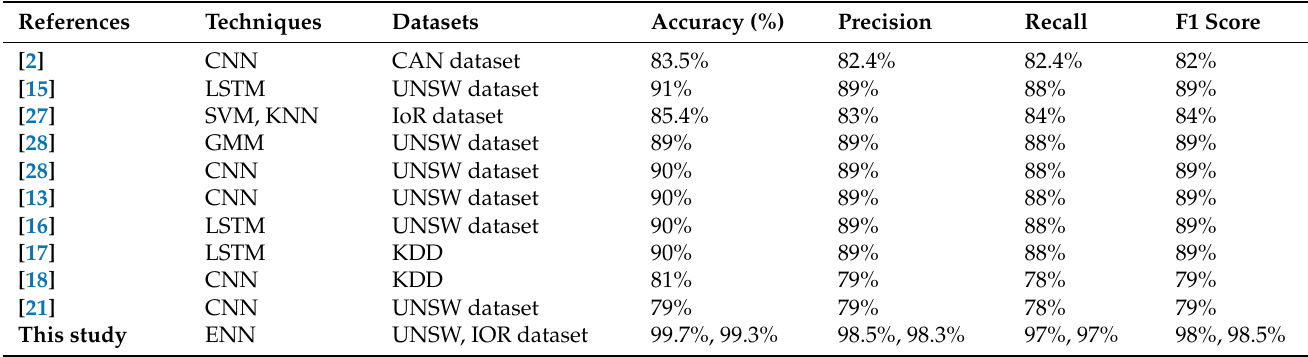
Table 4. Comparative Analysis of Previous and Current